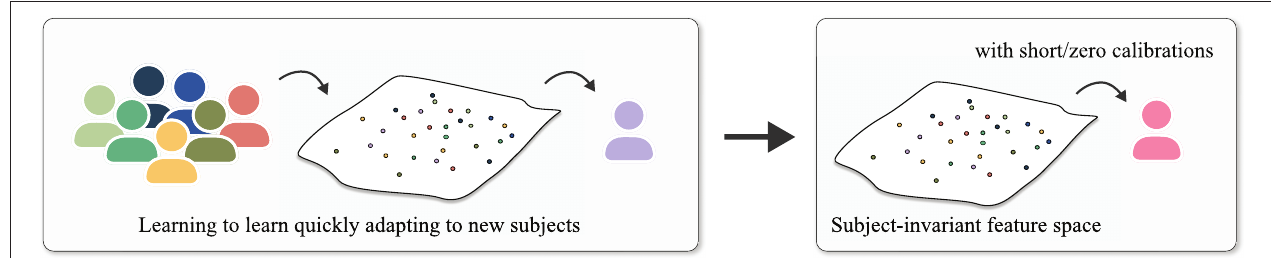
FIGURE 9 | Conceptual illustration of meta-learning in BCI. Meta-learning aims to learn how to quickly adapt to new subjects by updating parameters based on a variety of tasks acquired from multiple subjects. Subsequently, the trained feature space can be considered as subject-invariant space that can be efficiently applied to new subjects with short/zero